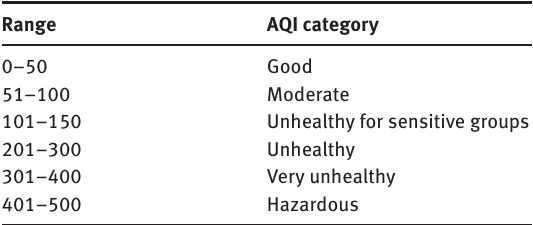
Table 1: Proposed Categories of AQI (0–500) by the US EPA. Range